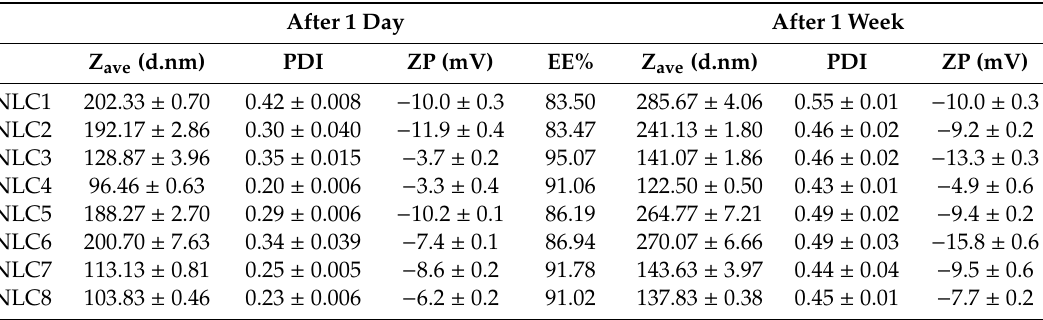
Table 2. The particle size, zeta potential, PDI and entrapment e ffi cacy of the NLC compositions (mean and ± SD). After 1 Day After 1 Week